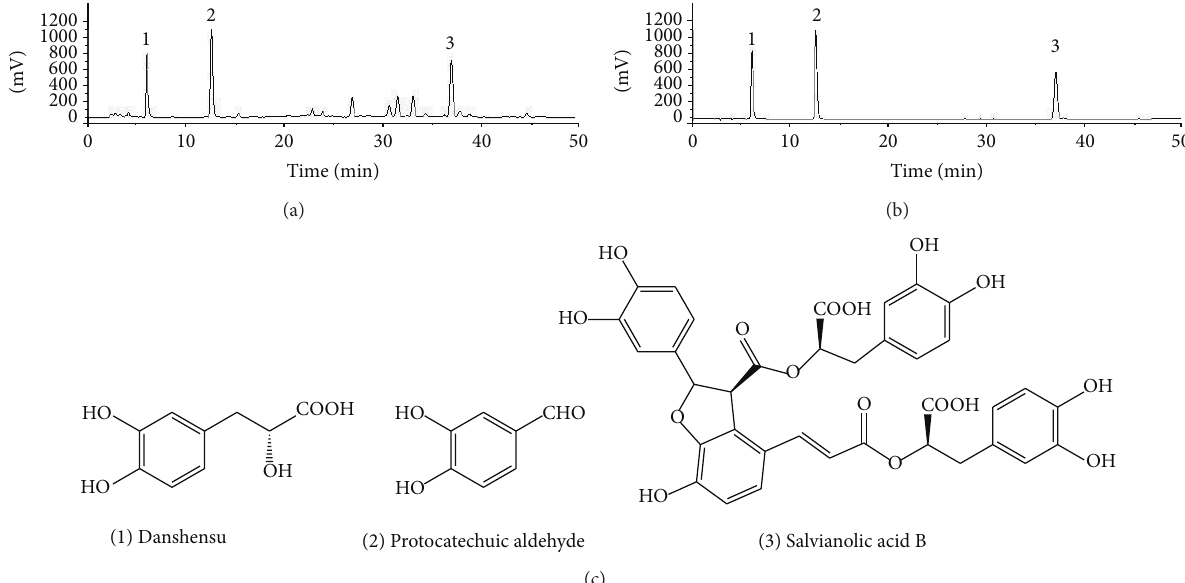
Figure 1: HPLC-UV profiles of SM injection, standards, and chemical structures of the active ingredients. HPLC-UV profiles of SM injection (a) and standards (b), and the peaks represented (1) danshensu; (2) protocatechuic aldehyde; (3) salvianolic acid B. (c) The chemical structures of the three active ingredients.